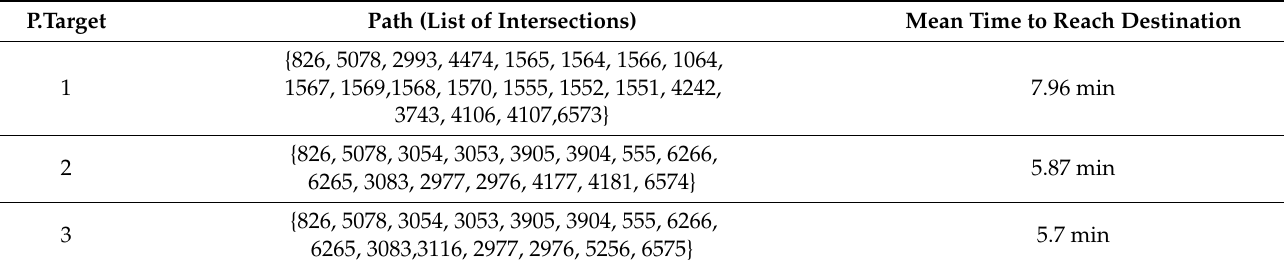
Table 2. Paths for Different Classes of People Living PN I-826.